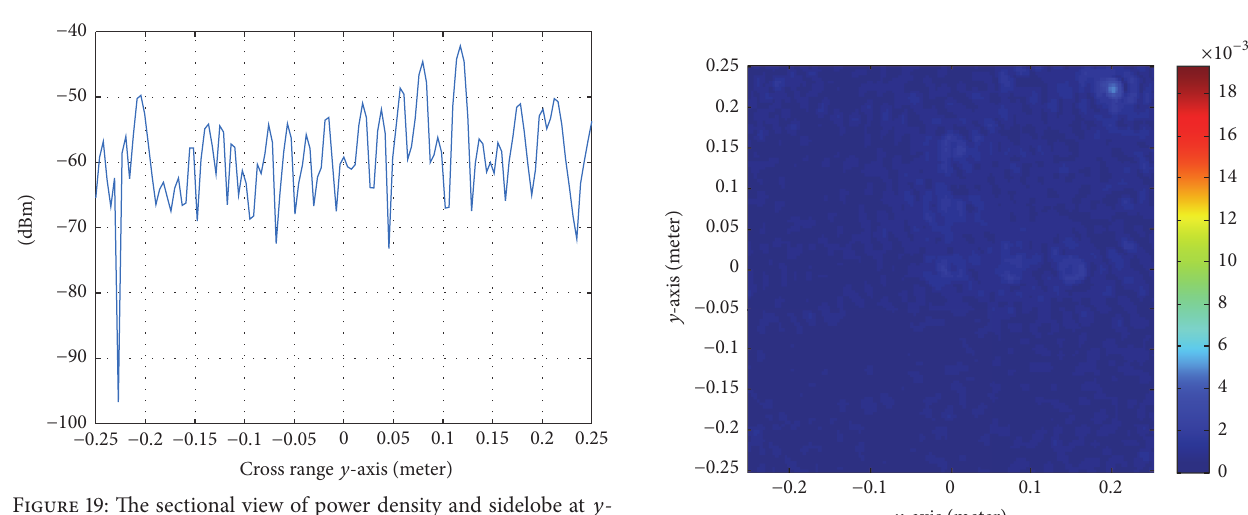
Figure 20: Initial tomographic image reconstruction of noisy extended complex target, showing only the dominant target before applying MRL algorithm.